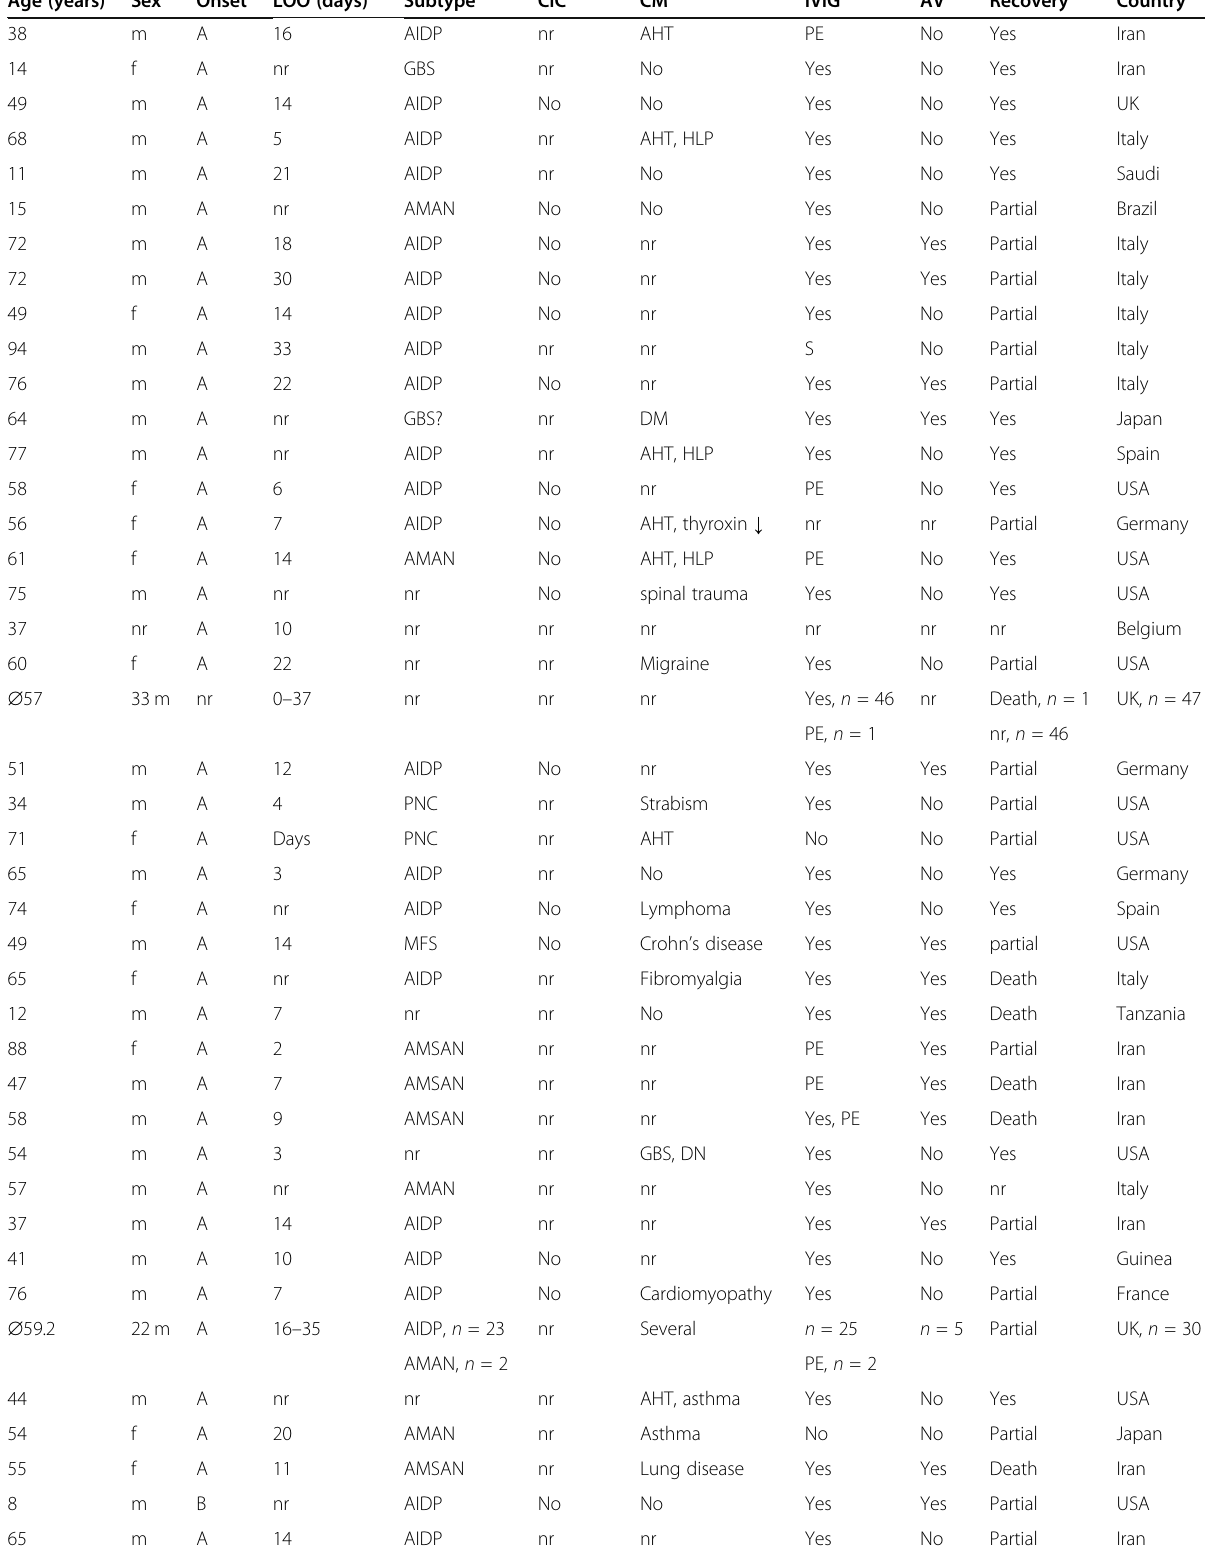
Table 1 Patients with SARS-CoV-2 associated polyradiculitis as reported by the end of December 2020 (Continued) Age